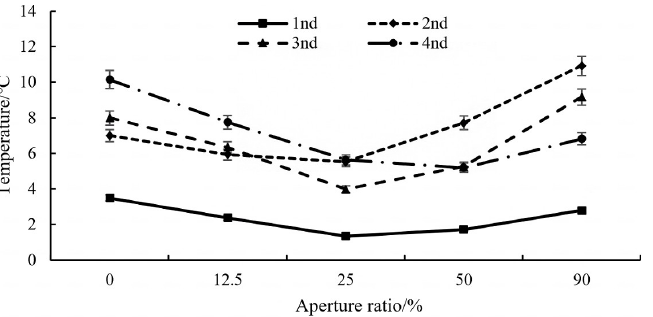
Figure 4. The influence of different aperture ratios on the temperature of each shelf inside the cabinet.